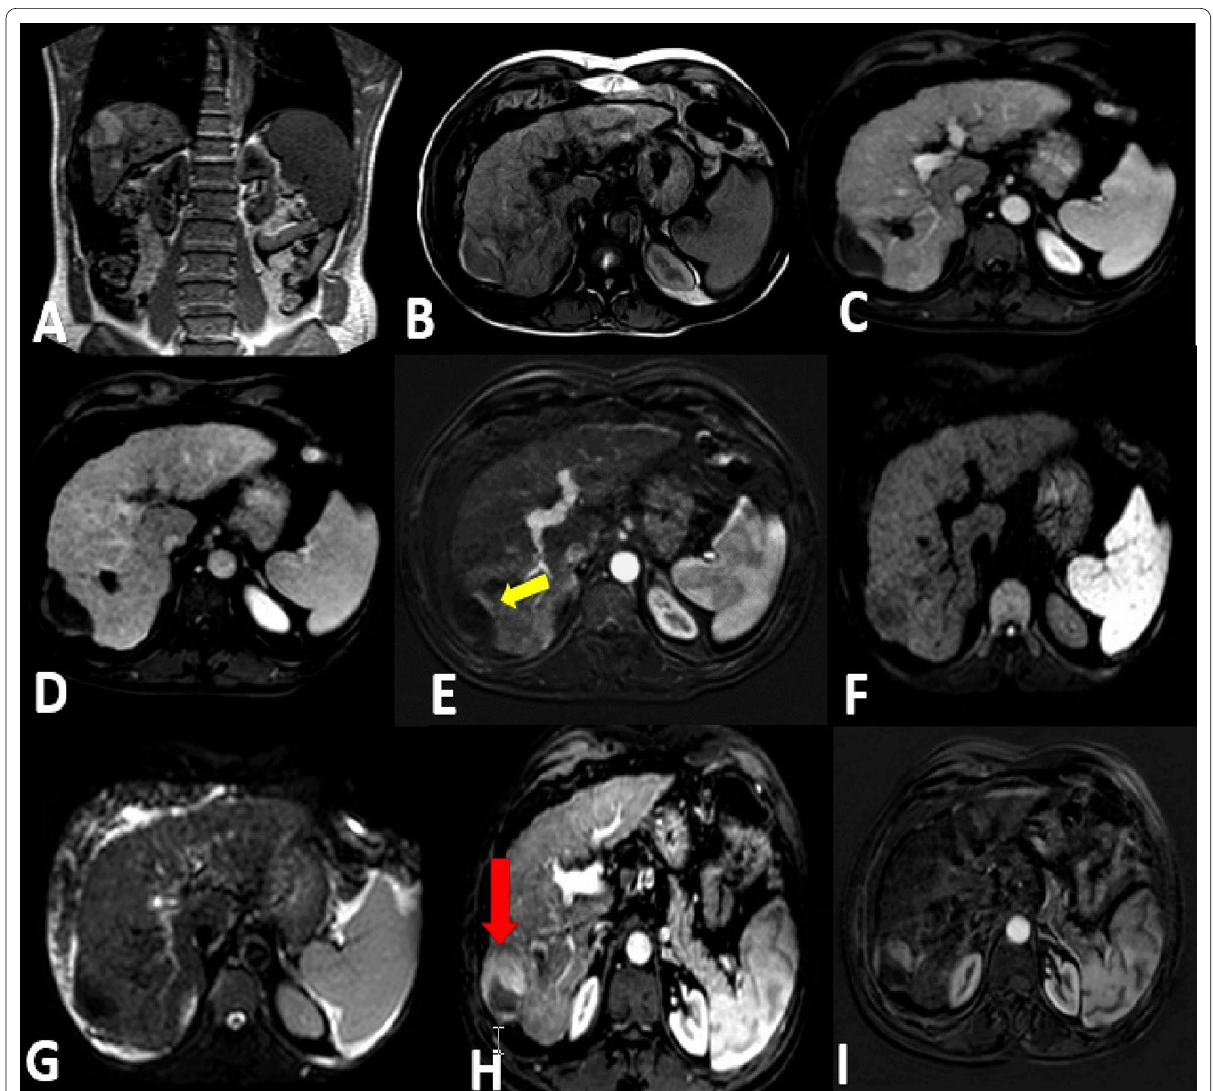
Fig. 7 A 60‑years‑old male patient with cirrhosis having RF ablation for right lobe focal lesion, dynamic MRI was done with subtraction technique 1 month after RF ablation, a , b coronal and axial T1WI with the ablated focal lesion appearing heterogeneously Bright, c early post contrast thrive showing bright inconspicuous crescentic area along the medial margin of the hypointense lesion. d Delayed thrive the marginal area being isointense to the adjacent liver parenchyma; e subtraction augmented the presence of encasing crescentic lesion along the medial margin (yellow arrow) increasing the degree of confidence and accuracy. f Inspite of absence of diffusion restriction, based on subtraction findings with active tumoral residue Follow‑up after 6 months revealed increase in tumor size, h T1 post contrast increased enhancing residual tumor implicating the upper and lateral margins as well (red arrow), i also confirmed by